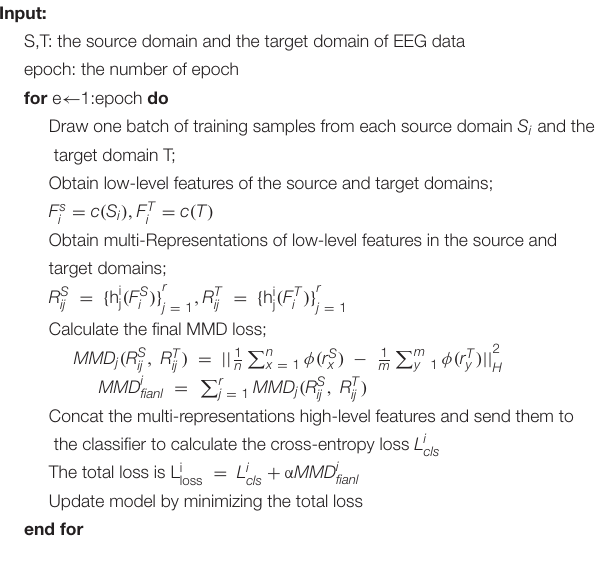
ALGORITHM 1 Overview of MSMRA